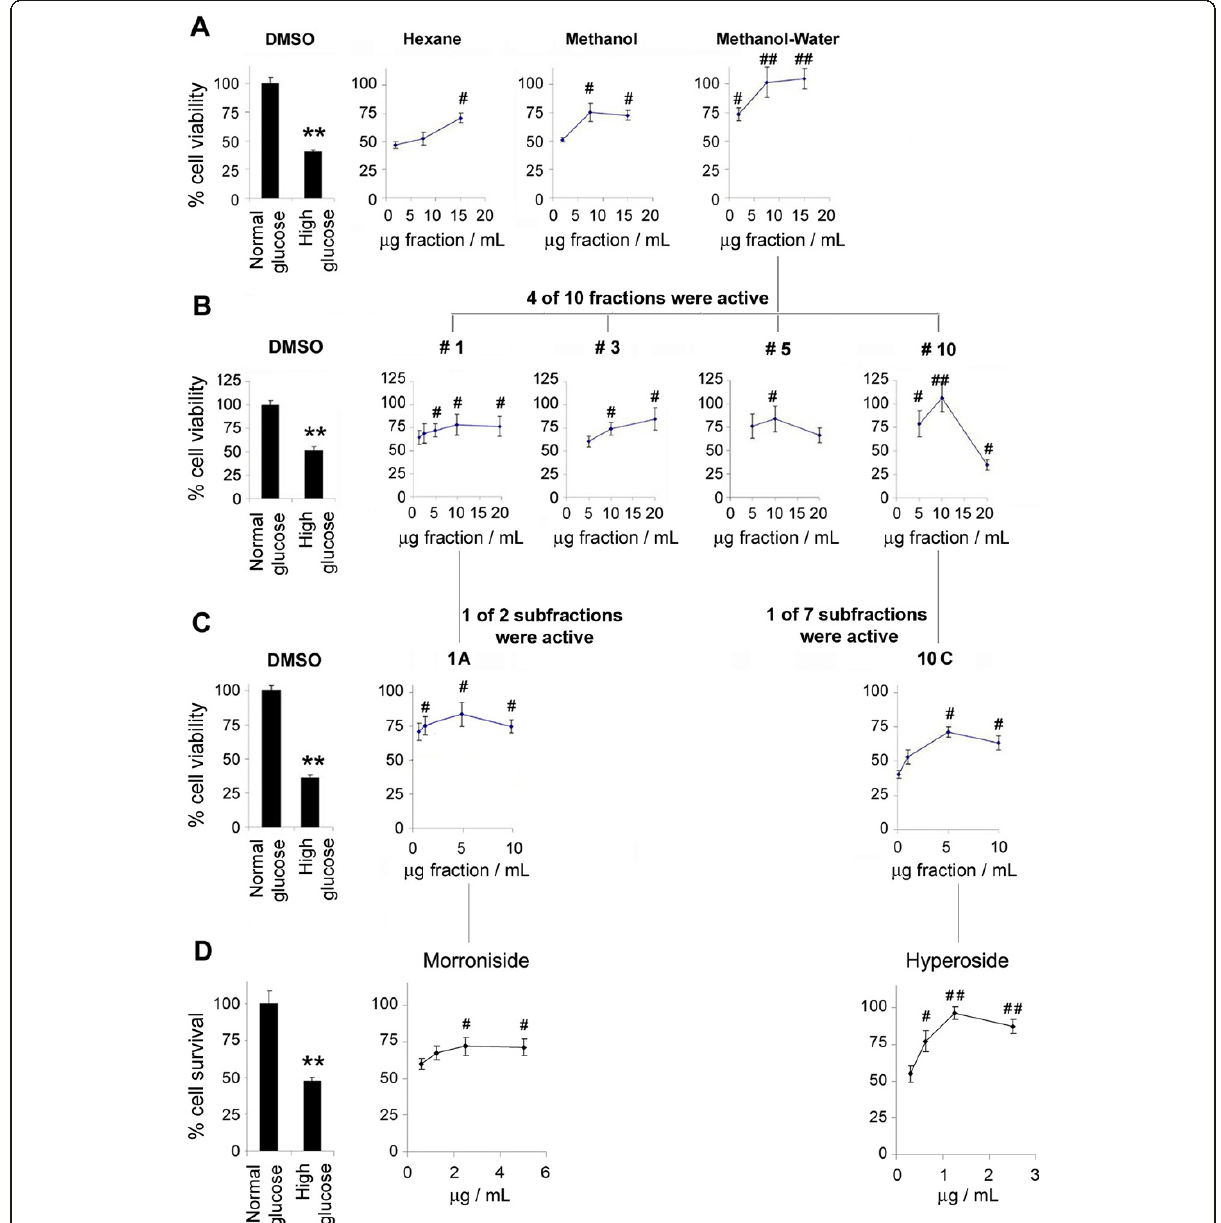
Figure 3 Activity-guided fractionation of Sarracenia purpurea leaf extract. In the first phase the crude leaf extract was fractionated based on solubility in hexane, methanol and water. ( A ) Each of the solvent fractions was evaluated in the glucose toxicity cell viability assay using WST and the methanol-water fraction was selected for further fractionation by Sephadex LH-20 column chromatography. ( B ) Each of the subsequent fractions was similarly evaluated with four of ten demonstrating significant cytoprotection. Fractions #1 and #10 were selected for further fractionation by semi-preparative HPLC. ( C ) Upon evaluation of resulting subfractions using the WST assay, only subfractions #1A and #10C, significantly reduced cell loss. ( D ) The concentration dependent protective activities of pure morroniside (>95%), the predominant metabolite in fraction #1, and hyperoside (>95%), the predominant metabolite in subfraction #10C, were confirmed using the Live/Dead cell survival assay. In left panels, ** denotes a significant difference ( p < 0.01) relative to normal glucose control (Student ’ s t -test, n = 8-12). In right panels, # and ## denote significant differences ( p < 0.05 and ## p < 0.01, respectively) relative to corresponding high glucose control (ANOVA, post-hoc Dunnett ’ s t -test, n =